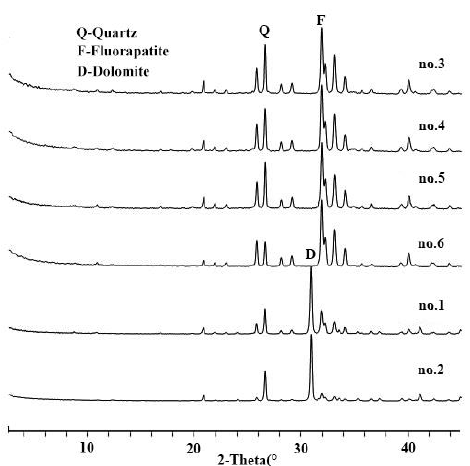
Figure 1. X-ray di ff raction (XRD) patterns of studied phosphorite samples. Figure 1. X-ray diffraction (XRD) patterns of studied phosphorite samples. Figure 1. X-ray diffraction (XRD) patterns of studied phosphorite samples.